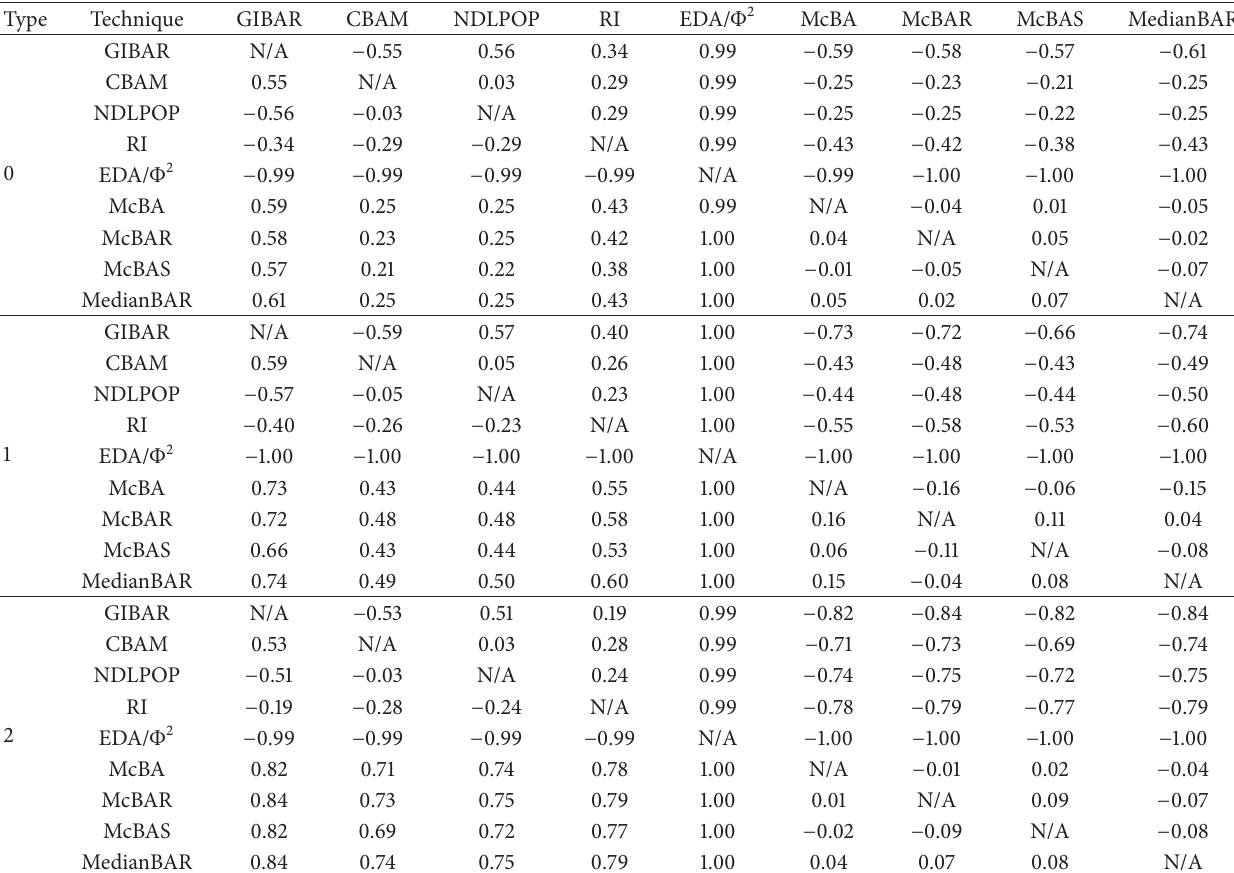
Table 9: Average E 𝜏 𝑡 [⋅] performance under change types 0 to